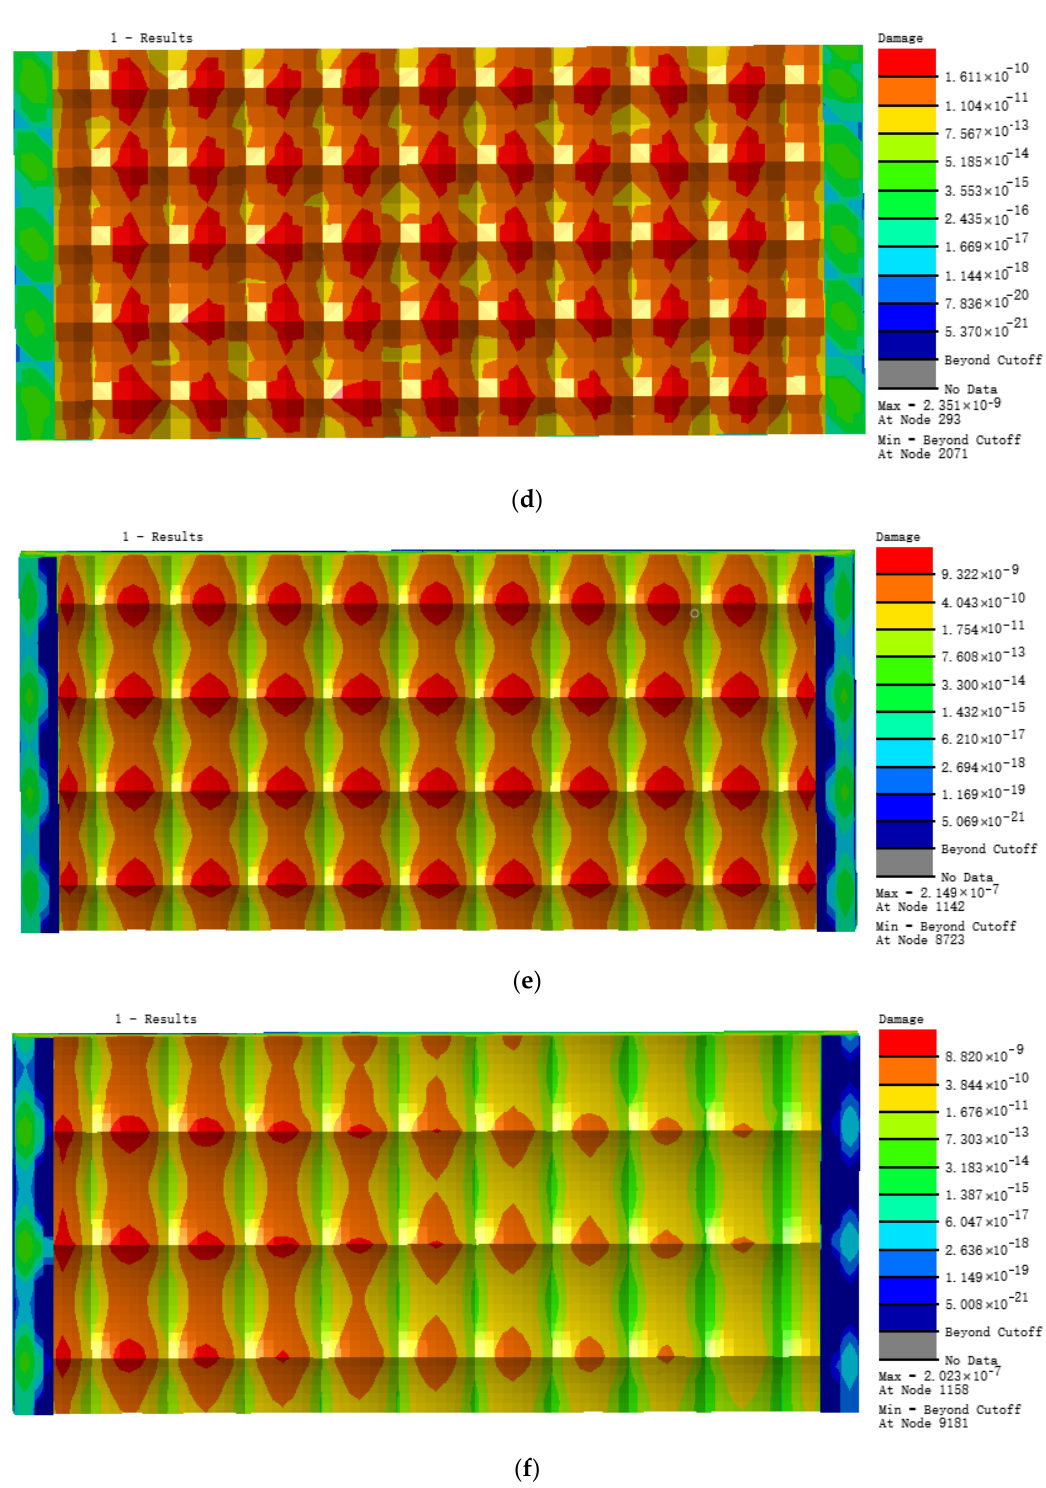
Figure 11. Nephograms of fatigue damage. ( a ) A1 model; ( b ) A2 model; ( c ) A3 model; ( d ) A4 model; ( f ) A5 model; ( e ) A6 model.